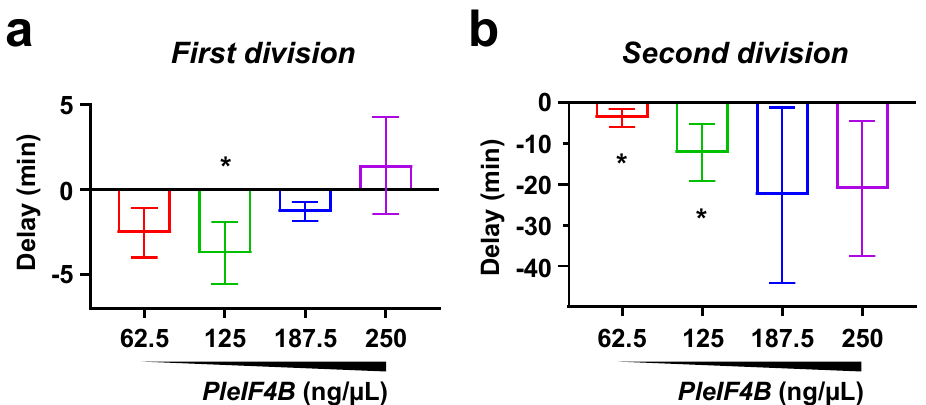
Figure 4. Microinjection of P. lividus eIF4B mRNA accelerates cell division. ( a , b ) Graphs representing the time delay (min) observed at first ( a ) or second cleavage ( b ) in embryos injected with increasing doses of PleIF4B . Times correspond to 50% cleavage completion and values obtained in the 250 ng/ µ L Firefly luciferase mRNA injected embryos were used as a reference to calculate delays. Negative delays thus indicate that the embryos develop faster than the reference population. In each experiment, different amounts of Firefly luciferase mRNA were added to reach a constant mRNA concentration of 250 ng/ µ L. For each condition, 100 eggs were microinjected, fertilized, and monitored throughout early development. Error bars represent the SEM of four independent experiments. (Mann-Whitney test: * p -value < 0.05).